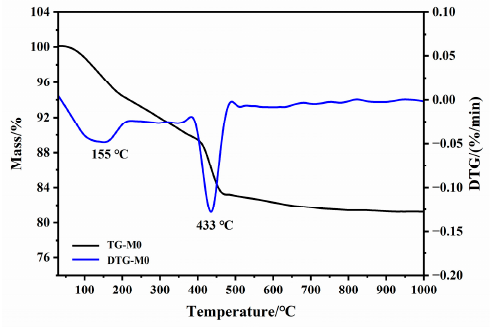
Figure 4. TG-DSG curves of hydrated cement M0.